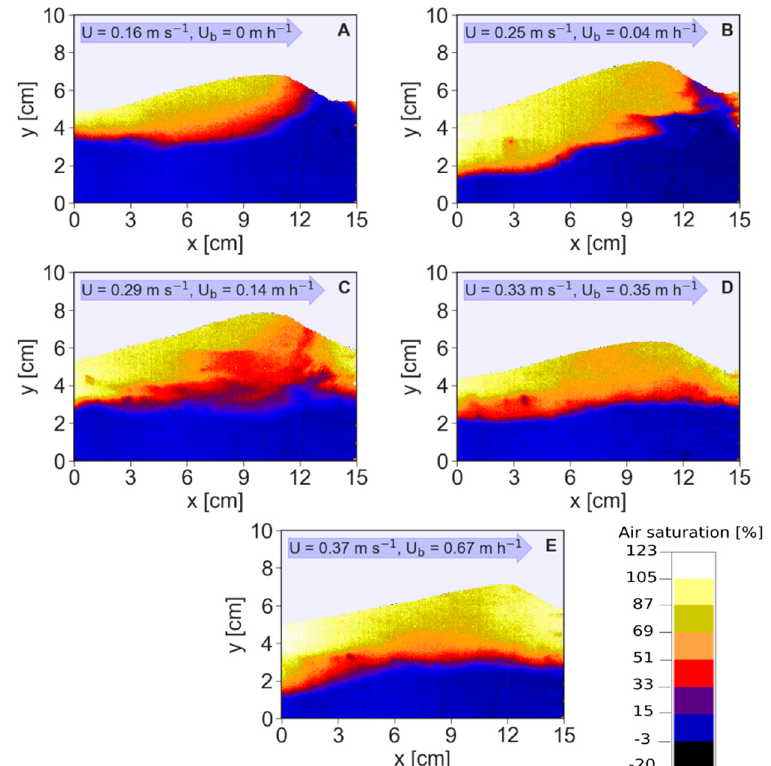
Figure 2. Optode images showing spatial oxygen distributions in the streambed under increasing streamflow velocities (U) and bed form celerities (U B ), from stationary conditions to the fastest bed form celerity. Streamflow velocities (U) and bed form celerities (U B ) are shown on Panels A–E. Images and videos of the other flow conditions are given in the Supplementary Material.